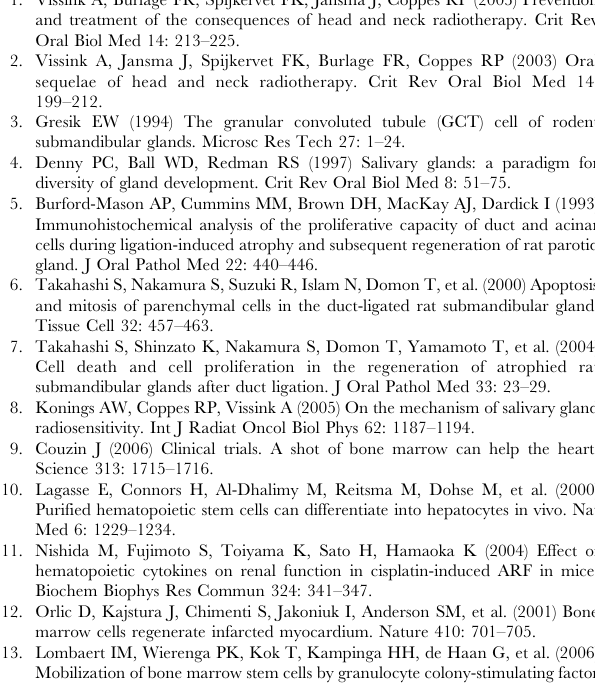
Figure S1 Sca-1 EXPRESSION IN DUCTAL AND ENDO- THELIAL CELL TYPES. Expression of Sca-1 on endothelial and duct cells was confirmed using Sca-1(Ly-6A) GFP transgenic mice. (B,C) The GFP signal overlapped with the specific duct cell marker CK 7 (C enlargement of B) or CD31 + (D, enlargement in E), and a -smooth muscle actin myoepithelial (MY) cells (F, enlargement in G) remained negative for GFP expression. (H) Culture of Sca- 1(Ly-6A) GFP salivary gland cells revealed GFP expression in duct cells whereas polarized acinar cells were negative (D0-inset). After 3 days of culture, only cells at the periphery of the sphere showed high Sca-1 GFP expression (D3). Cells were visualized with DAPI (blue, A–G) or PKH-26 (H, red). Scale bar= 50 m m, in- set =20 m m. D = ductal cell type, MY=myoepithelial cell, BV = blood vessel, D0 and D3 represent days in culture. Figure S2 VISUALIZATION OF GFP EXPRESSION BY FLUORESCENCE AND BRIGHT FIELD MICROSCOPY. (A) GFP was not expressed in all cells of glands from GFP transgenic donor mice, and was absent in recipient irradiated glands from normal mice prior to transplantation (B). GFP + transplanted cells were present in the injected area (C, enlargement in E), and GFP was also detected in duct compartments in the surrounding area (D, enlargement in F). Fluorescent GFP data were confirmed using anti-GFP antibody (G–L) for light microscopy. Scale bar= 50 m m, inset = 20 m m. Nuclei are stained in blue.